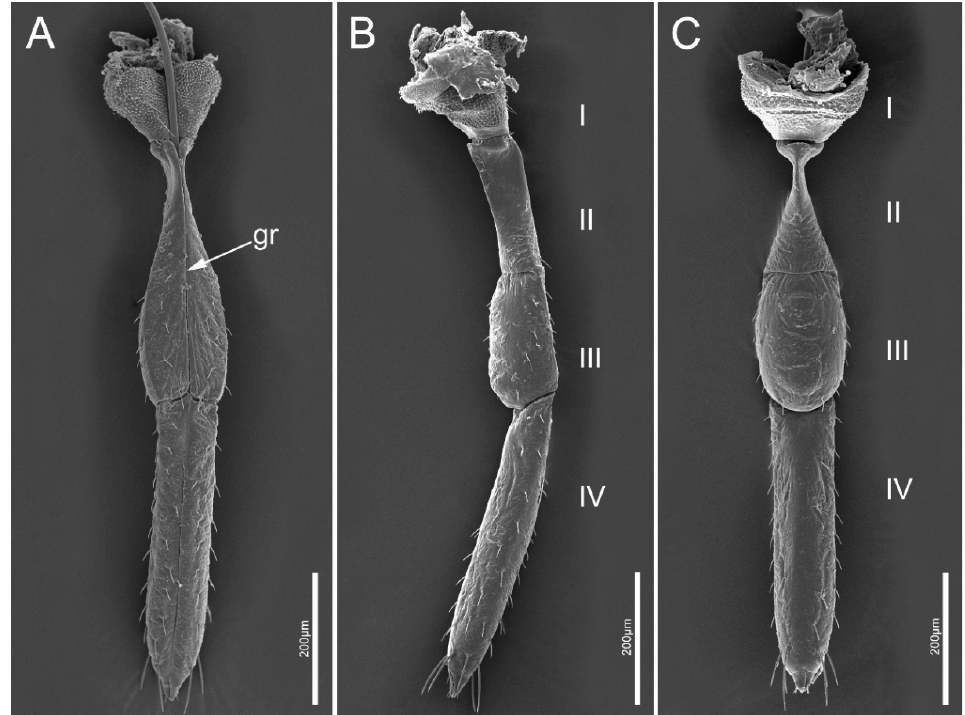
Figure 4. General morphology of the labium of Mezira yunnana . ( A ) Ventral view showing the lon- gitudinal groove (gr); ( B ) lateral view showing the four labial segments (I–IV); ( C ) dorsal view show- ing the four labial segments (I–IV). showing the four labial segments